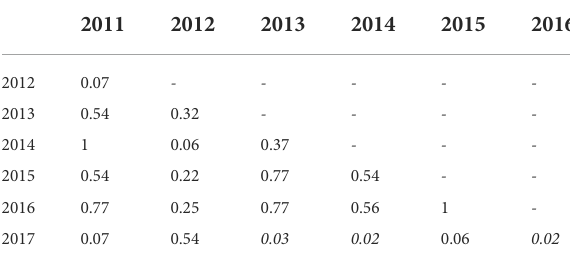
TABLE 4 Mean Simpson diversity indexes for each year were compared with a pairwise Wilcoxon rank sum test with the Benjamini – Hochberg (BH) p -value adjustment. In this table, all site types (unoiled, oiled, and reference) are pooled within the year they were collected. Signi fi cant values are in italics and indicate a statistically signi fi cant difference in the mean diversity between two years.